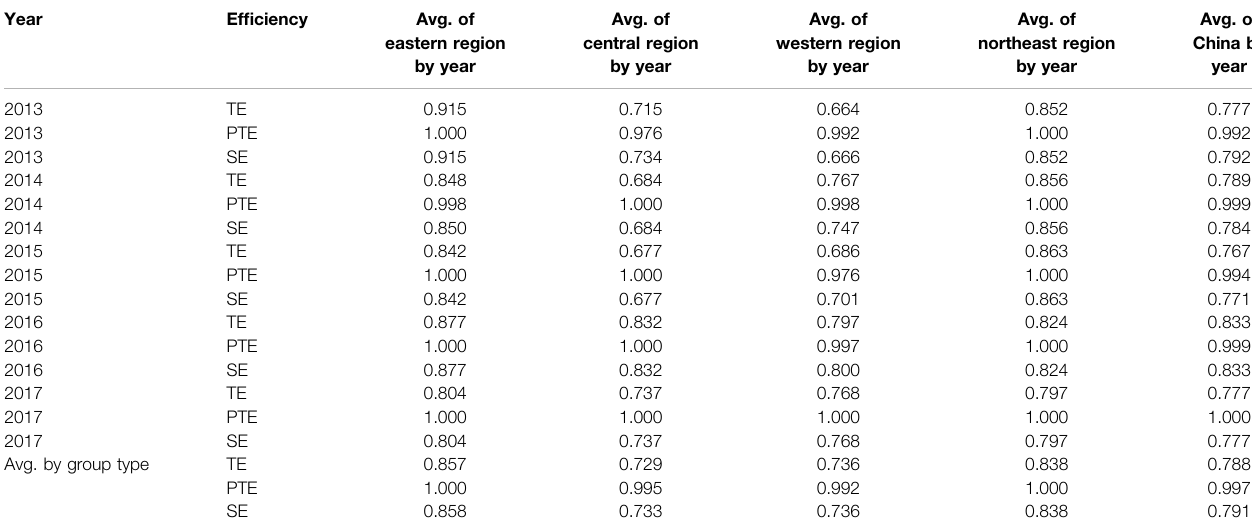
TABLE 6 | Average technical ef fi ciency